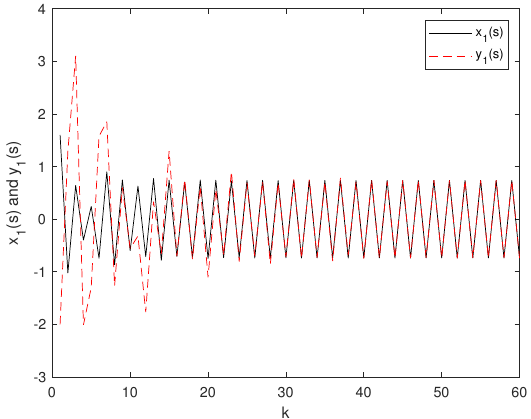
Figure 6. Trajectory curves of x 1 ( s ) and y 1 ( s ) with controller.